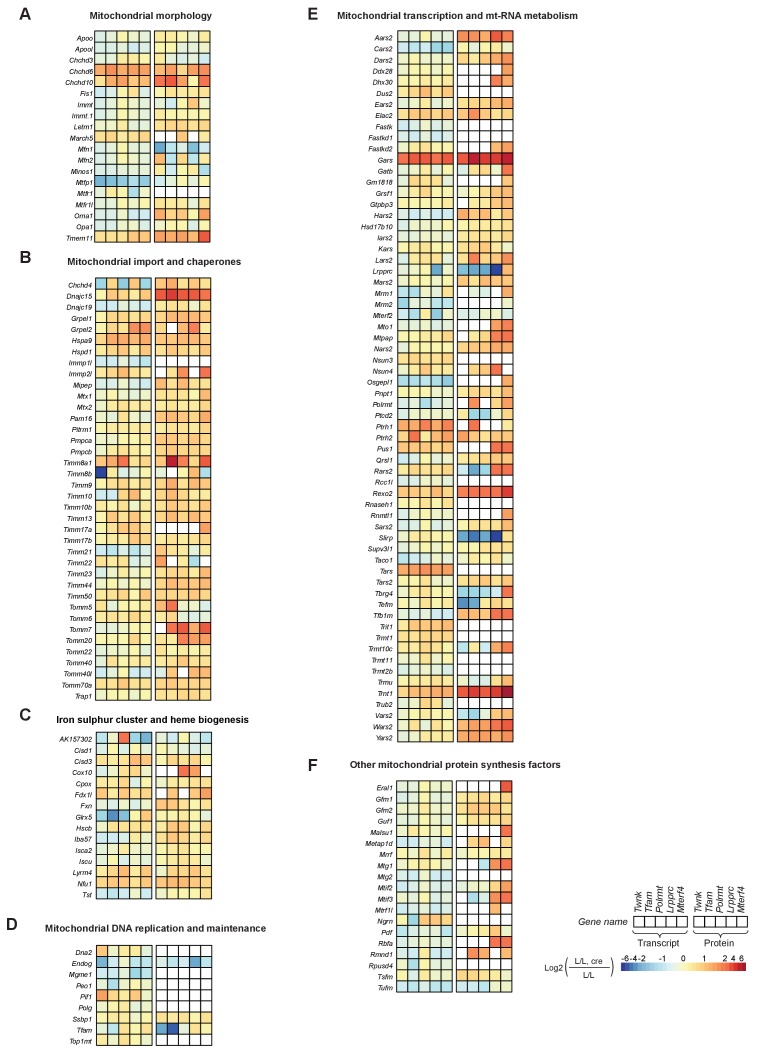
Proteins regulating mitochondrial morphology, iron sulphur cluster and heme biogenesis are increased.Heatmaps illustrating the fold-change transcript (left) and mitochondrial protein (right) levels in L/L, cre and L/L mouse hearts in alphabetical order; blank boxes in heatmap: not identified or not quantified. Adjusted p<0.05 in at least one of the knockout mouse strains for the genes encoding mitochondrial transcript or protein levels. (A) Mitochondrial morphology. (B) Mitochondrial import and chaperones. (C) Iron sulphur cluster and heme biogenesis. (D) Mitochondrial DNA replication and maintenance. (E) Mitochondrial transcription and mt-RNA metabolism. (F) Other mitochondrial protein synthesis factors.